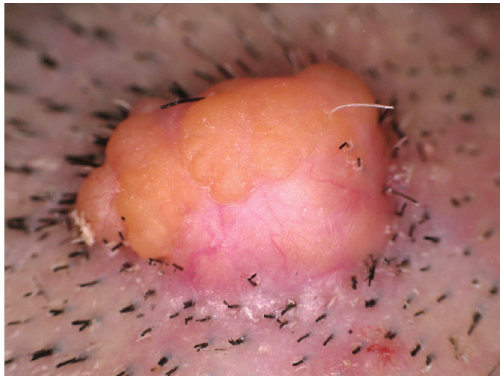
Figure 1: A dome-shaped faintly pinkish nodule. The surface of the tumor was covered with yellow papules.